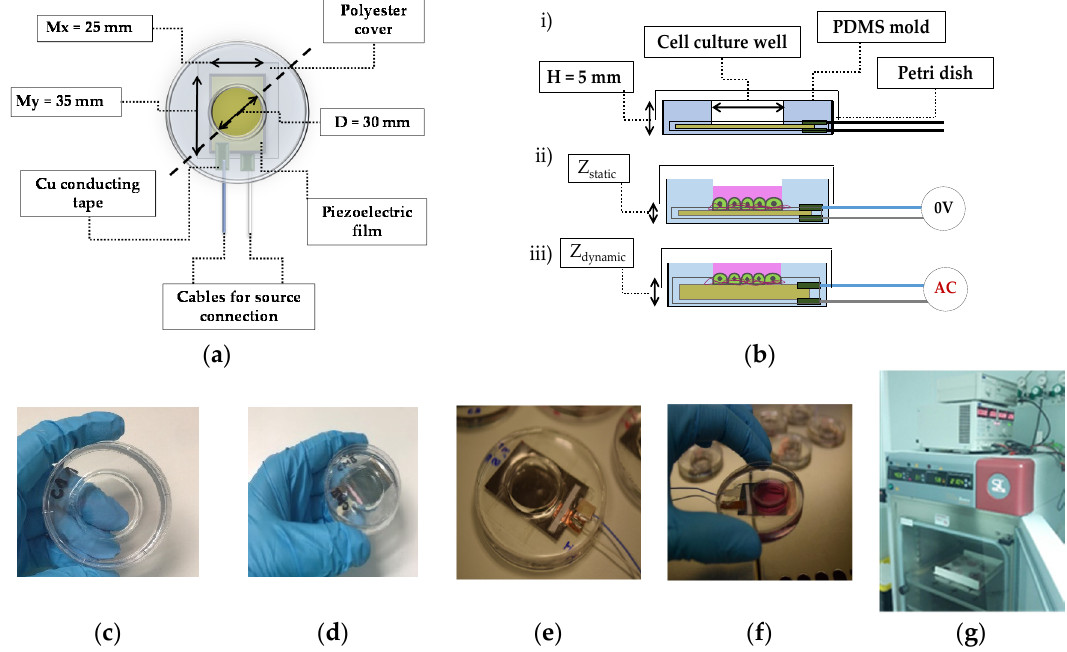
Figure 2. ( a ) description of the conformational domains in the experimental stage based on a PVDF actuator; ( b ) lateral view of the schematic representation shown in ( a ). (i) the PVDF film is in the bottom of the Petri dish and a PDMS mold achieves the cell culture well. (ii) and (iii) show a cell culture with basal medium and cell cultures confined within the PDMS mold and with the PVDF film as a substrate (under static condition (ii) (0 voltage in the electronics stage) and dynamic condition (iii) (AC voltage in the electronics stage); ( c ) control set for all the experiments; ( d ) control set of the piezo device for static conditions; ( e ) dynamic set for cell culture stimulation at a determined frequency and amplitude (it is noted the external cable connections); ( f ) handling cell cultures on the piezoelectric devices inside a biosecurity cabin; ( g ) the piezoelectric system containing the HaCaT cells is placed inside the cell culture incubator with a lateral hole to allow electrical access (a signal generator, power supply, and the driver is observed outside the incubator).